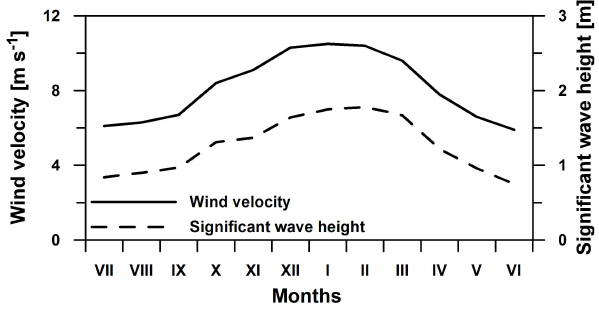
Fig. 2. Monthly 75%-iles of wind velocity and significant wave height calculated for the studied